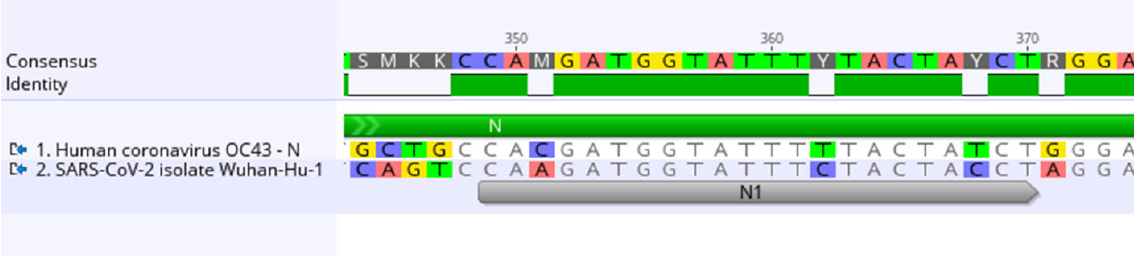
Figure 1. Comparing HCoV-OC43 (GenBank: AY585228) and SARS-CoV-2 (GenBank: NC_045512.2) CRISPR target sequences. Mismatches between HCoV-OC43 and SARS-CoV-2 sequences are high- lighted based on nucleotide.